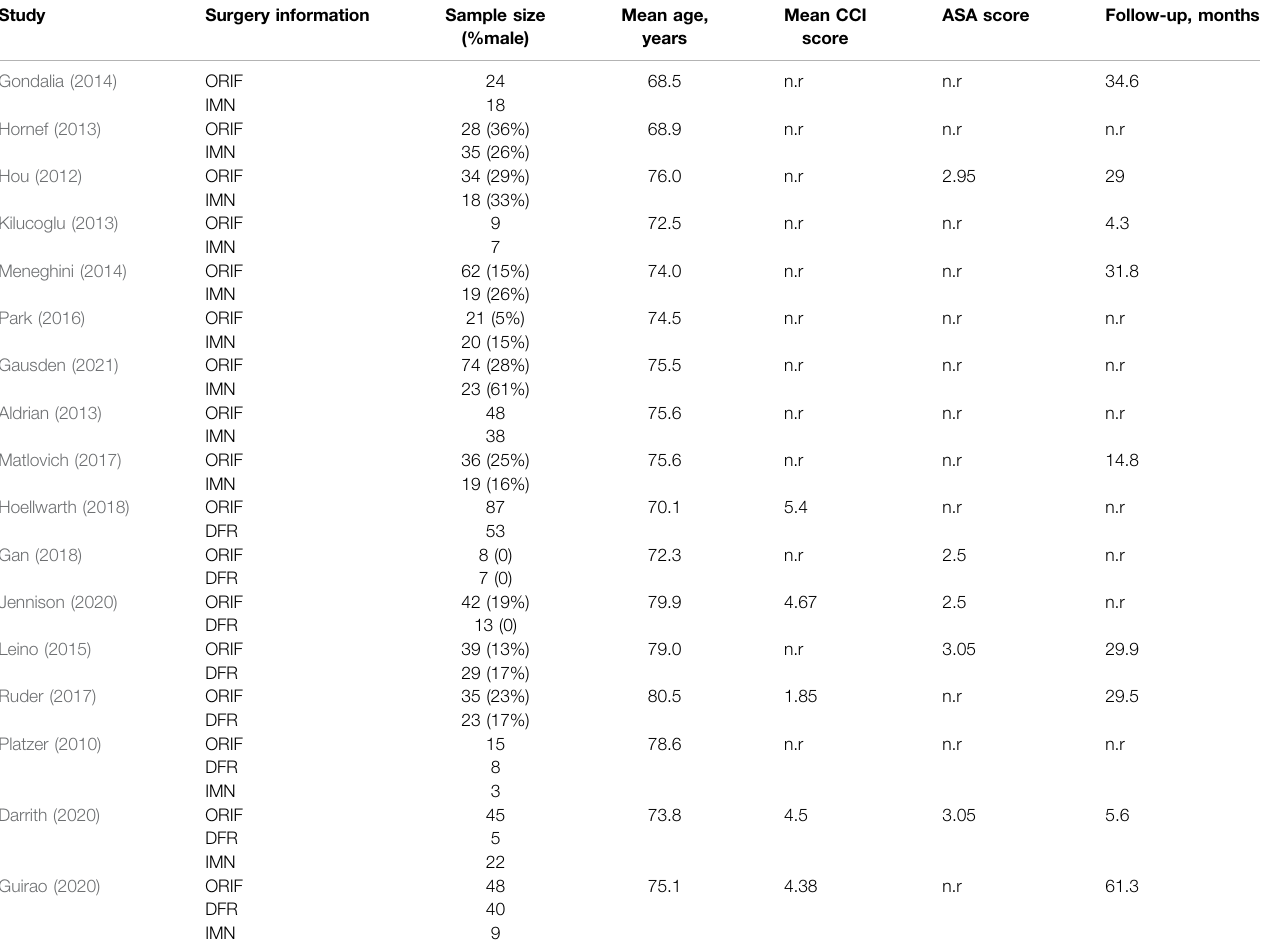
TABLE 2 | Characteristics of patients in eligible studies ( n = 16).